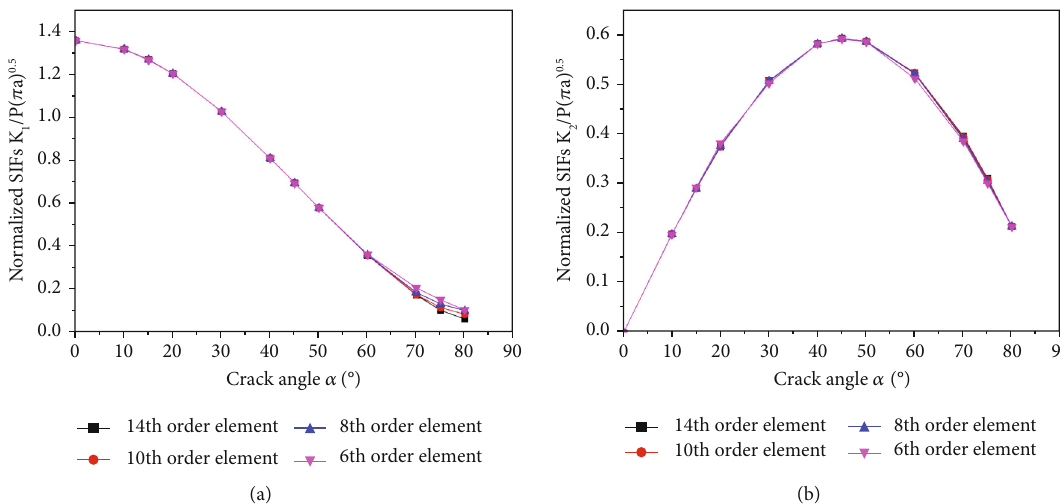
Figure 5: The relationship between SIF and crack angle under di ff erent element orders. (a) The normalized SIFs K crack angle under di ff erent element orders. (b) The normalized SIFs K